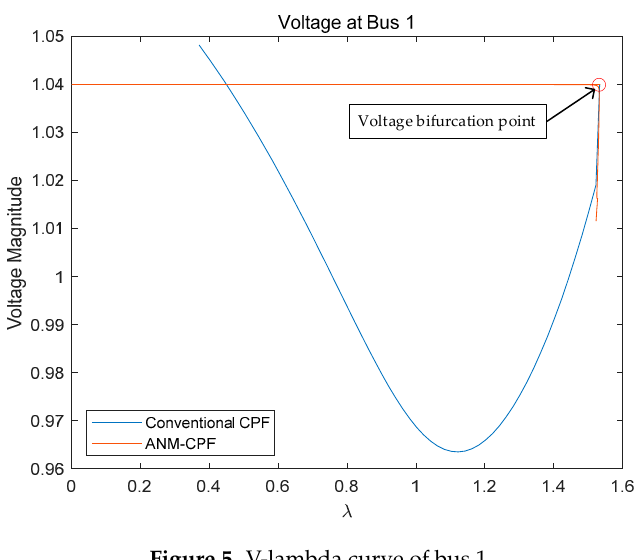
Figure 5. V-lambda curve of bus 1. Table 1. Calculation time of one point in PV curve for both methods.